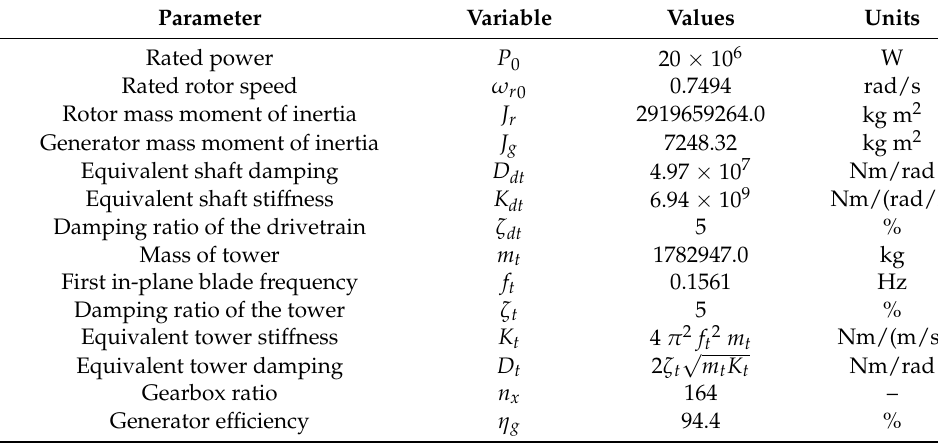
Table 1. Essential model